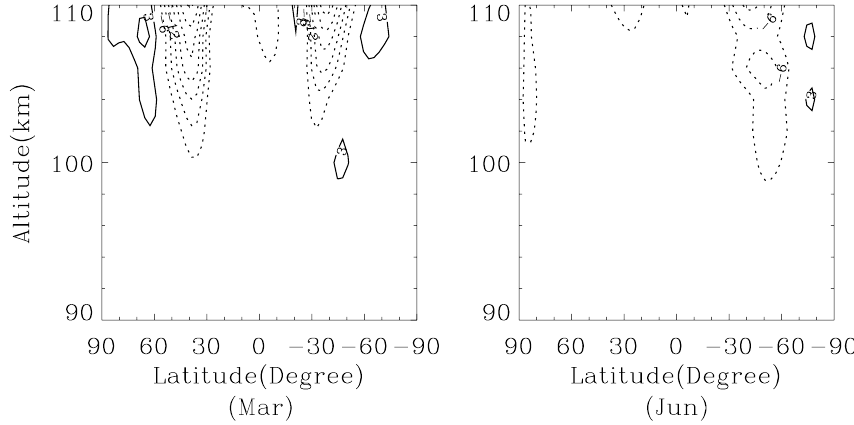
Fig. 5. Background zonal-wind alterations after 8 tidal periods for March (left) and June (right) deduced from the nonlinear propagation solutions of the migrating semidiurnal tide starting from the GSWM-00 tidal oscillations. The intervals of the contours are 3ms − 1 . The solid and dotted curves denote the positive and negative values, respectively.